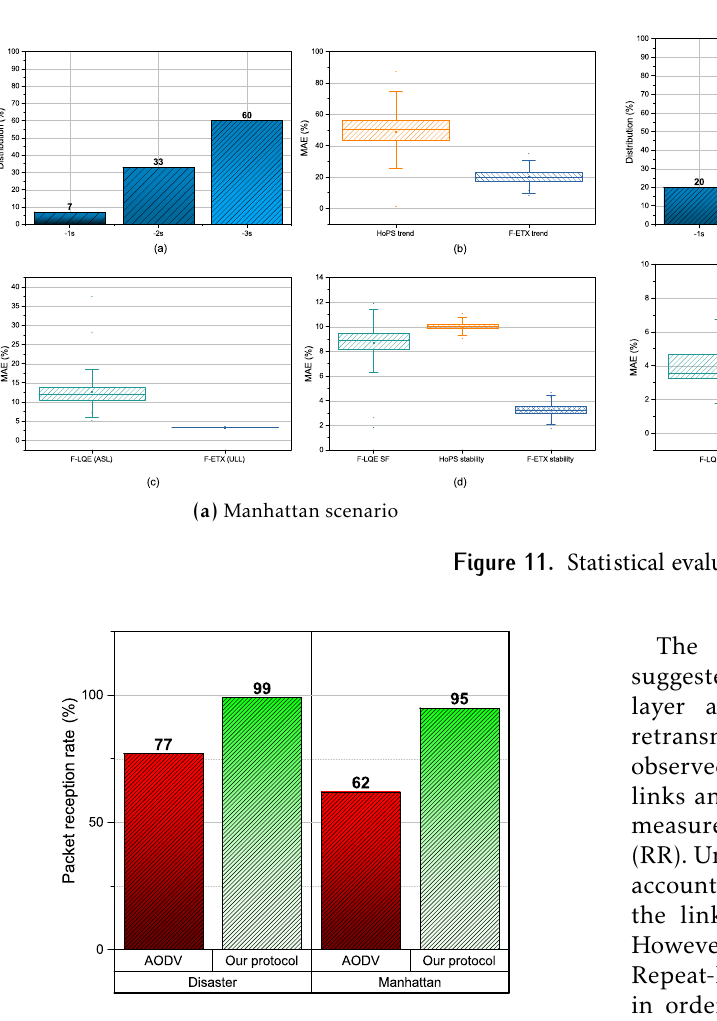
Figure 12. Packet